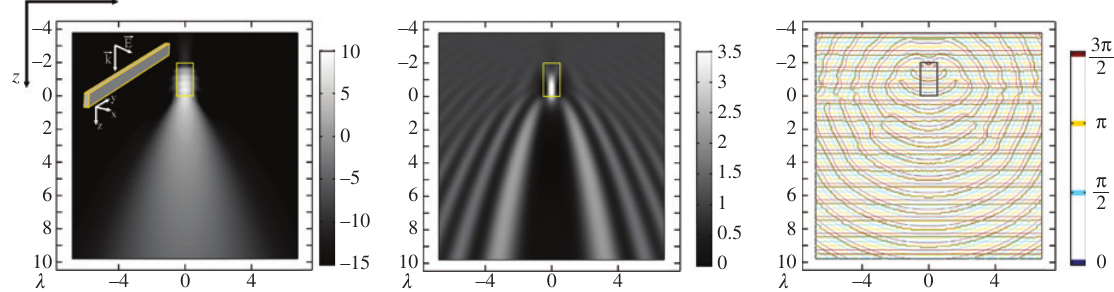
Figure 1: Calculated intensity patterns and phase map generated by a dielectric rectangular structure (W = λ , H = 2 λ , n = 1.4) in air with an incident plane wave (in-plane polarization). Left: scattered intensity pattern (logarithm scale). Middle: diffraction intensity pattern resulting from the interference of the scattered field with the incident field (linear scale). Right: phase maps of the scattered and incident fields. The spatial scales are normalized to λ .